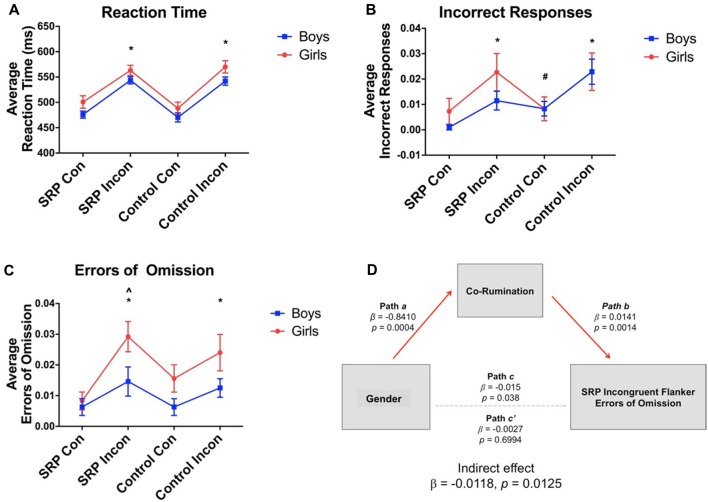
Flanker task performance (mean ± standard error of the mean; N = 49). Reaction time (RT) was slower (A) and more incorrect responses (B) and errors of omission (C) were made during incongruent vs. congruent trials, regardless of condition, as indicated by significant main effects of condition. Main effects of gender on RT and errors of omission were also observed, such that girls were slower to respond and made more errors than boys. Co-rumination fully mediated the effect of gender on SRP Incongruent errors of omission (D). *Compared to SRP Congruent and Control Congruent trials, p < 0.05, Šidák. #Compared to SRP Congruent trials, p < 0.05, Šidák. ∧Girls compared to boys, p < 0.05, Šidák. SRP, self-referential processing; Con, Congruent; Incon, Incongruent.